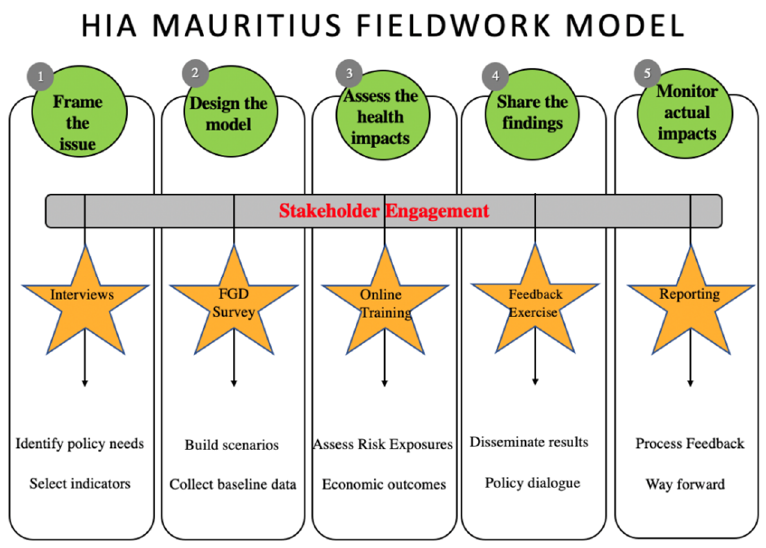
Figure 1. Baseline case-study fieldwork model.